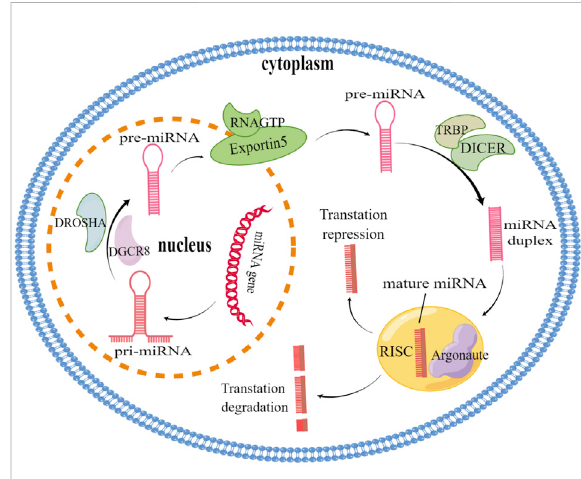
FIGURE 1 miRNA biogenesis and action. miRNA genes are transcribed by RNA polymerase II to produce primary miRNA (Pri-miRNA), Pri- miRNA is further processed by Drosha-Dgcr8 in the nucleus to formpre-miRNA,whichisthenexportedtothecytoplasm via Exportin5/Ran GTP. TRBP, and DICER in the cytoplasm further process the pre-miRNA into mature short double strand RNA fragments. One mature miRNA is associated with the Argonaute protein (AGO2) and binds to the 3 ′ UTR of the complementary site target mRNA of RISC leading to translation inhibition while the other strand is